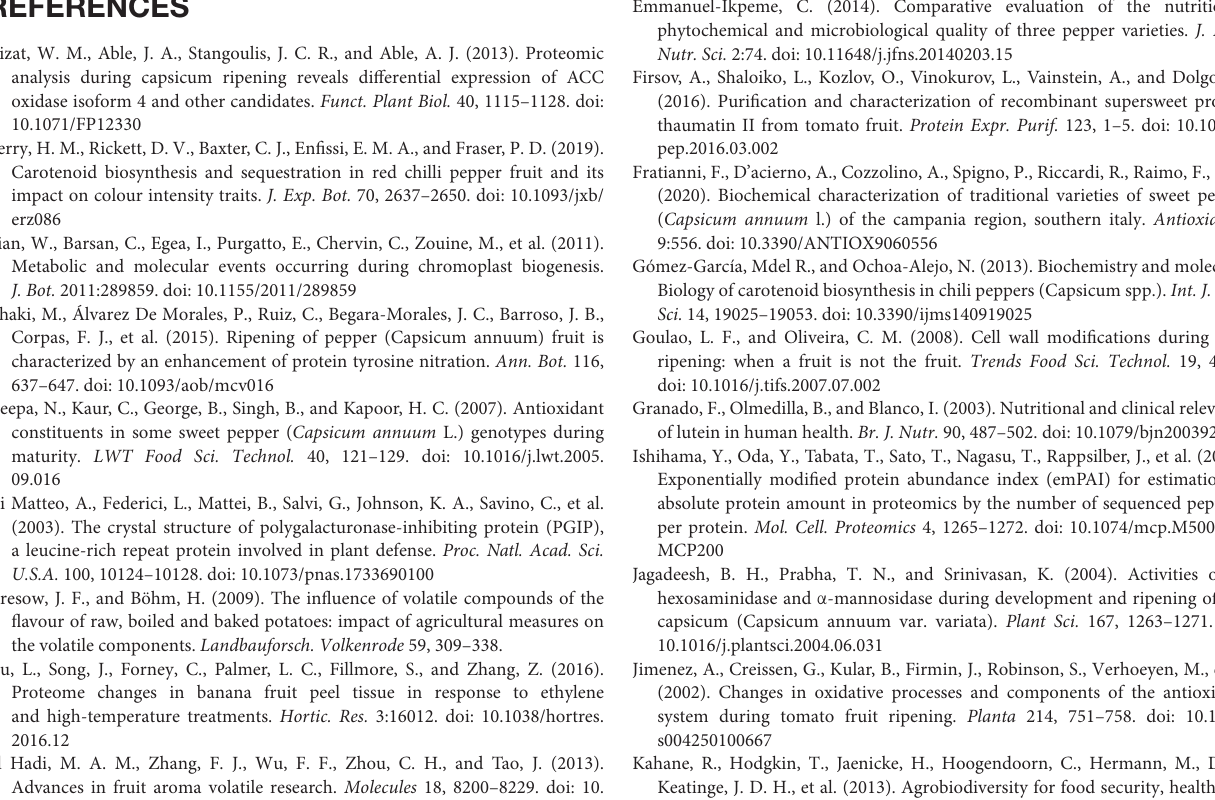
is reported for each sample, i. e. green, green/red, and red peppers. For each molecule is reported the specific aroma whereas it was